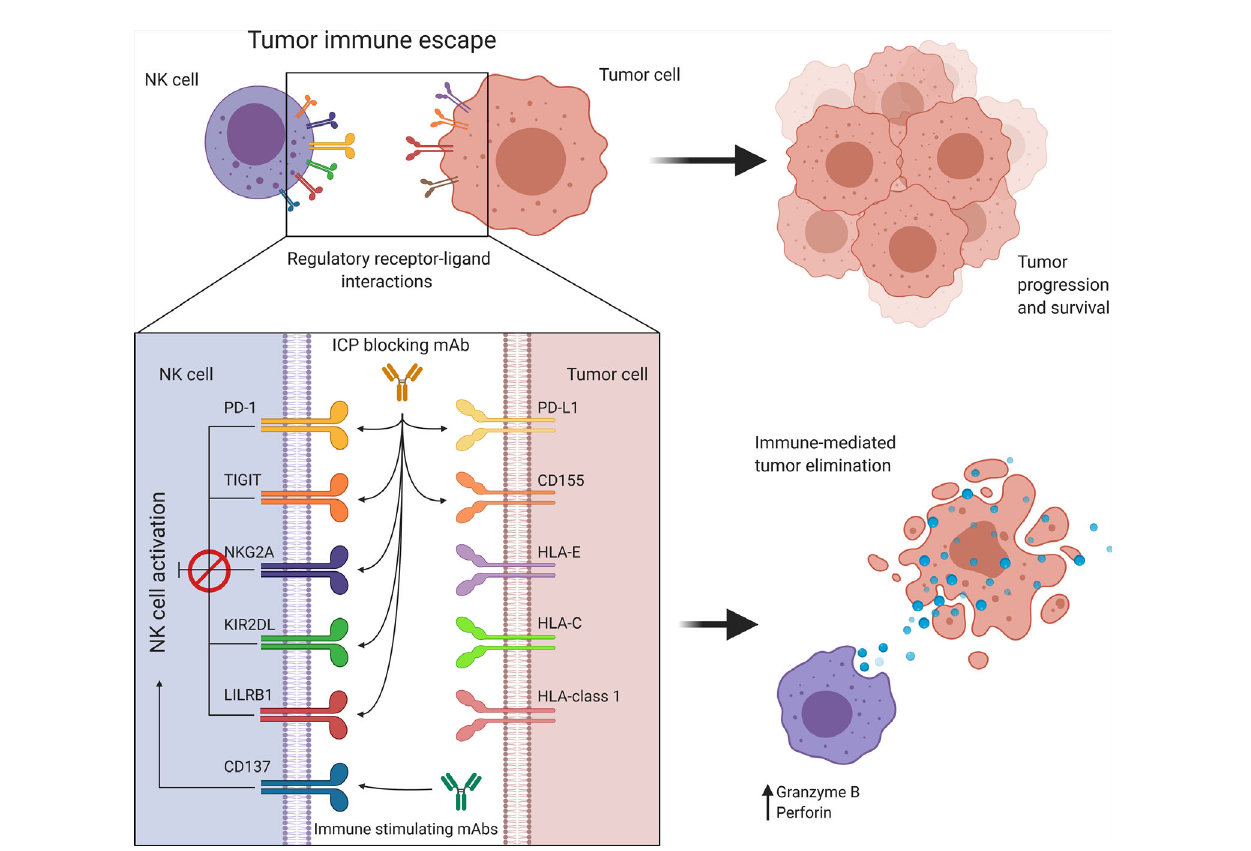
FIGURE 4 | Targeting immune regulatory molecules improves immune effector function against cancer. NK cell activity is regulated by a balance between immune activating and inhibiting interactions. Cancer promotes immune checkpoint expression to suppress NK cell activation allowing tumor immune escape and progression. Antibody-based immunotherapies suppress inhibitory signaling or further activate costimulatory signals to restore and enhance NK cell activity. HLA, Human leukocyte antigen; KIR, Killer cell immunoglobulin-like receptor; LILRB1, Leukocyte immunoglobulin-like receptor B1; NK, Natural killer; NKG2A, Natural killer group 2A; PD-1, Programmed cell death protein 1; PD-L1, Programmed cell death ligand 1; TIGIT, T cell immunoreceptor with Ig and ITIM